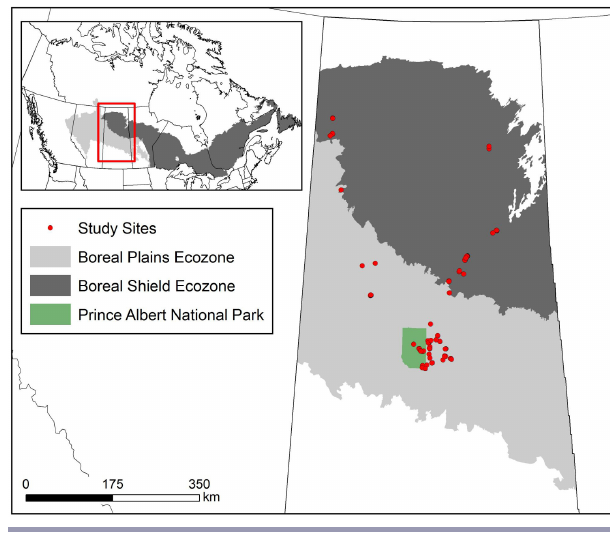
Fig. 1 . Distribution of 105 study sites (forest stands) surveyed using paired human observer and autonomous recording unit point counts ( n = 363) in the Boreal Plains ( n = 66 stands) and Boreal Shield ( n = 39 stands) ecozones.